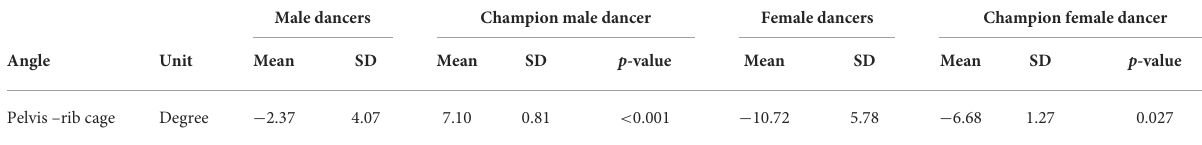
TABLE 5 Mean relative angle of the rib cage segment with respect to the pelvic segment in the vertical axis for the champion male and female dancers and the control group male and female dancers during the spin movement. Male dancers Champion male dancer Female dancers Champion female